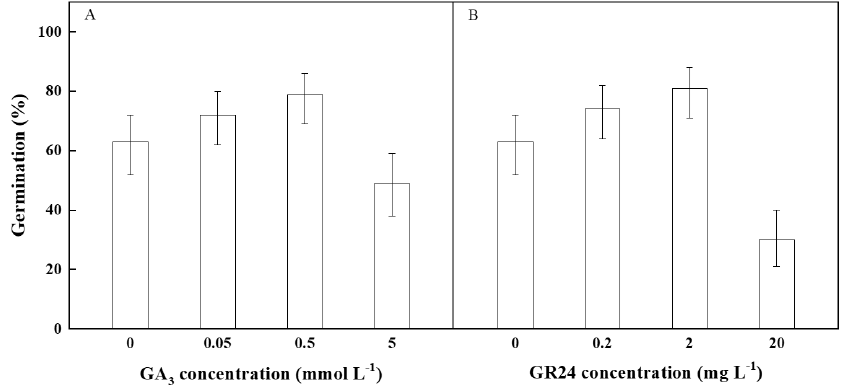
Figure 5. Germination percentage (±95% binomial confidence intervals) of P. kansuensis seeds treated with different concentrations of ( A ) GA 3 and ( B ) GR24 in 12 h light/12 h dark at 10/25 °C.